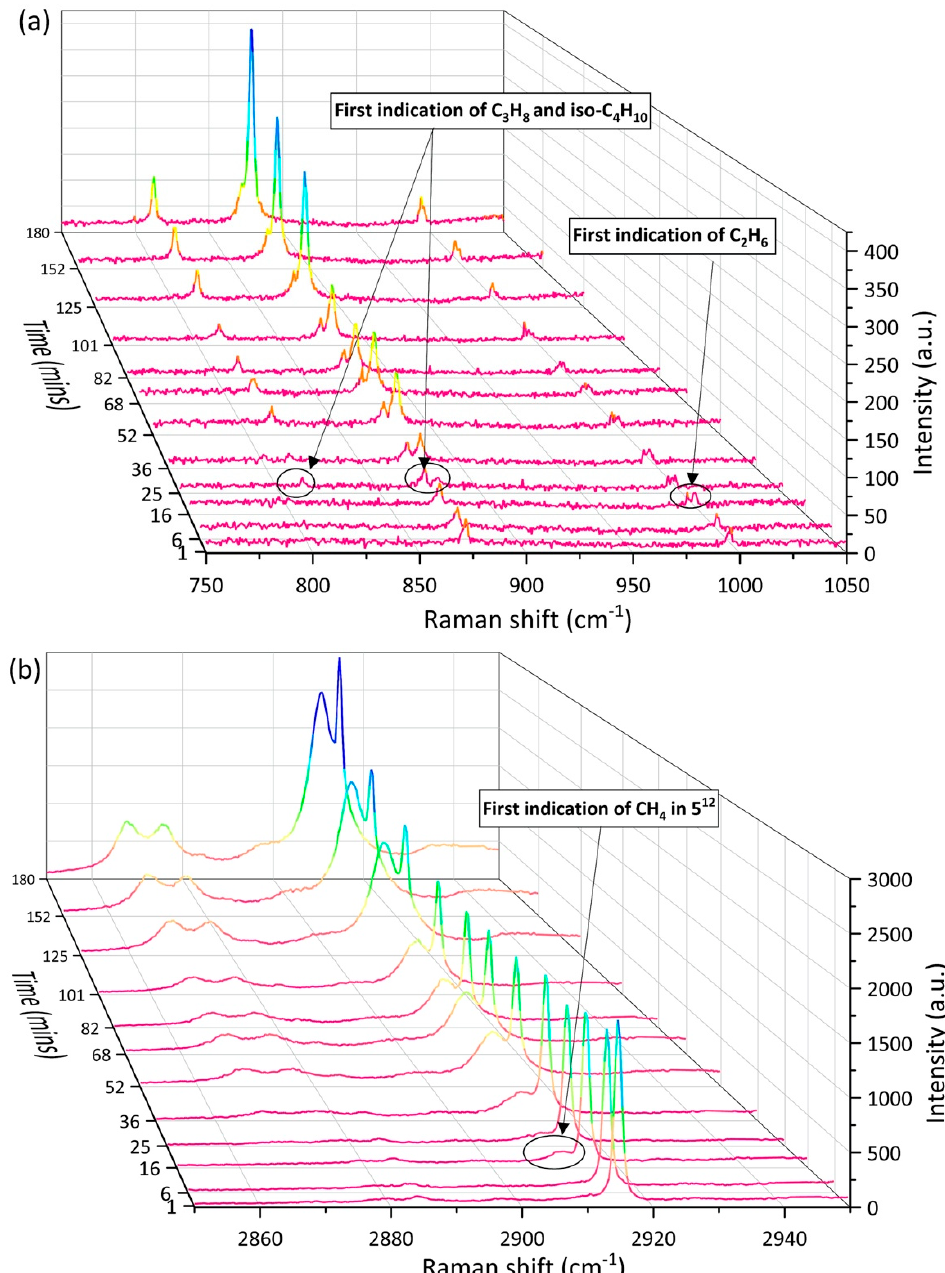
Figure 2. Time-resolved overview of Raman spectra in the ( a ) C–C stretching vibrational modes ranged from 700–1100 cm − 1 , and ( b ) C–H stretching vibrational modes ranged from 2840–2950 cm − 1 , as recorded on the surface of a hydrate crystal in the open system during the first 180 min.